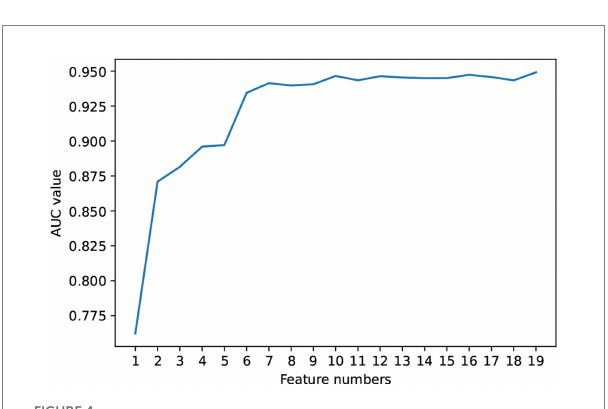
FIGURE 4 AUC values of random forest model versus number of top-ranked features.